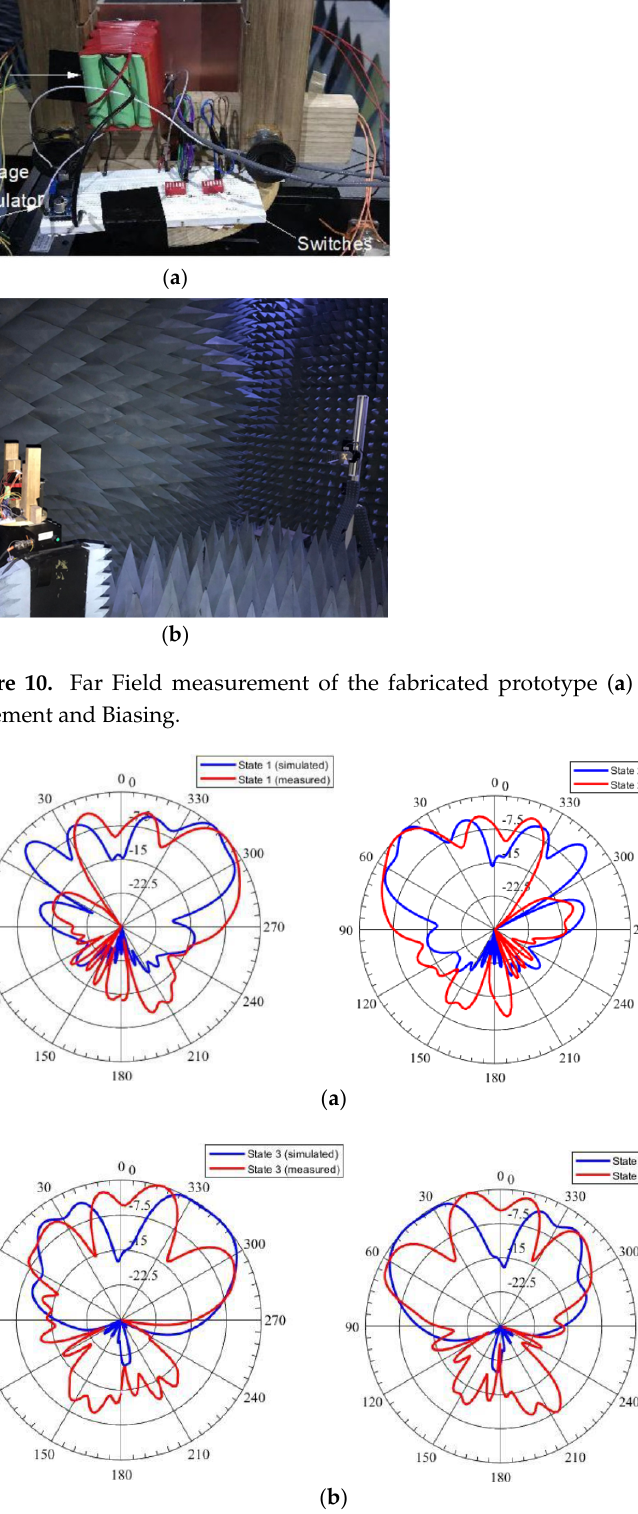
Figure 11. The radiation patterns result at 5.5 GHz ( a ) φ = 90° ( b ) φ = 0°.